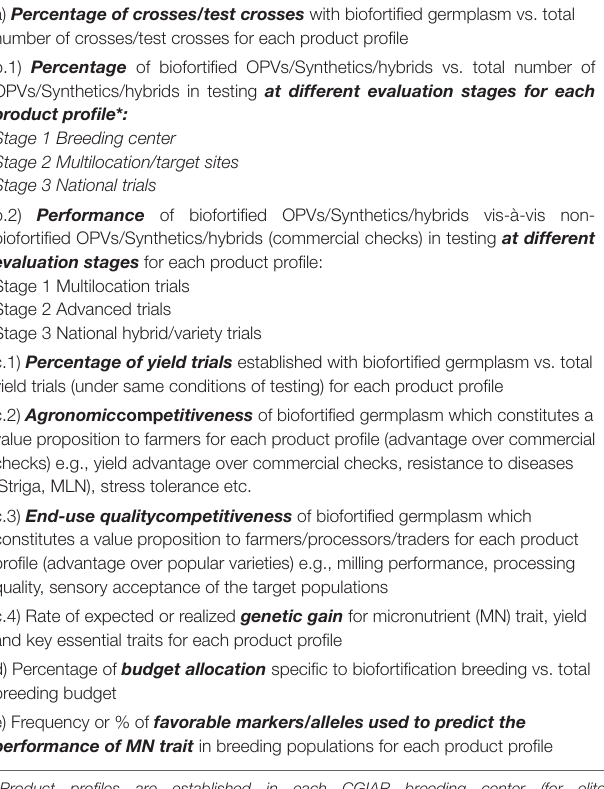
TABLE 4 | Indicators for assessing and monitoring the transition to mainstreaming of biofortification in cross-pollinating crops. a) Percentage of crosses/test crosses with biofortified germplasm vs. total number of crosses/test crosses for each product profile